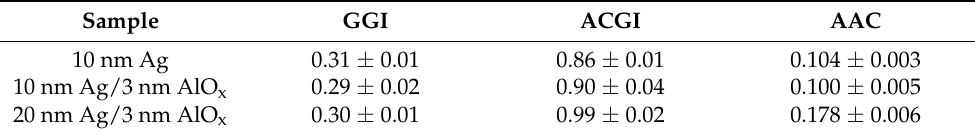
Table 2. Compositional ratios calculated from elemental concentrations measured with